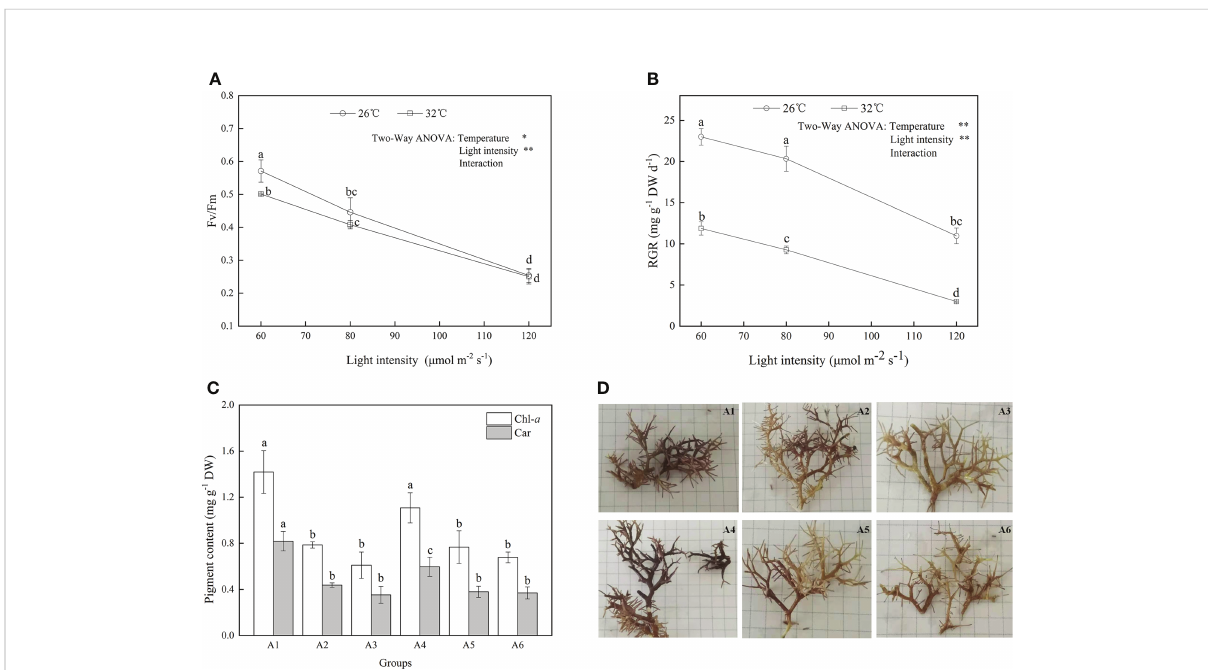
FIGURE 1 The (A) Fv/Fm, (B) relative growth rate, (C) pigment contents, and (D) morphological responses of A cf. fragilissima to increased temperature and light intensity (A1: 60 m mol photons m − 2 s − 1 , 26°C; A2: 80 m mol photons m − 2 s − 1 , 26°C; A3: 120 m mol photons m − 2 s − 1 , 26°C; A4: 60 m mol photons m − 2 s − 1 , 32°C; A5: 80 m mol photons m − 2 s − 1 , 32°C; and A6: 120 m mol photons m − 2 s − 1 , 32°C). Error bars correspond to the standard deviation with three independent replicates. abcd , Different letters implied signi fi cant differences ( P < 0.05) for each parameter. *P